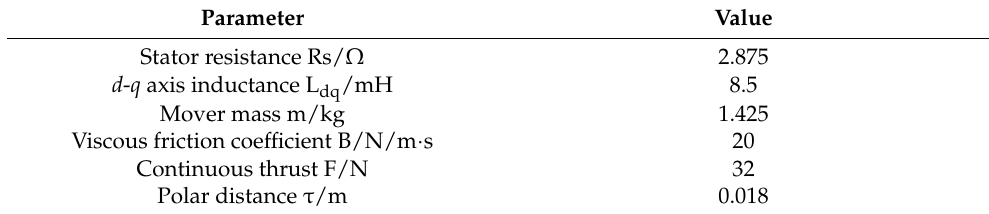
Table 1. The main parameters of motor.